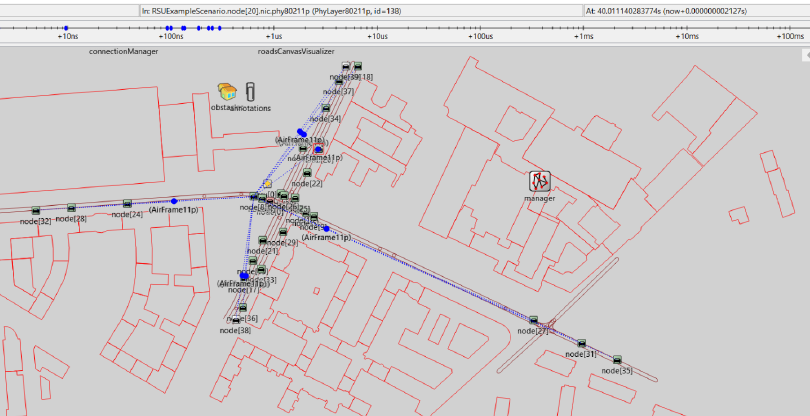
Figure 4. Real-world simulation map.